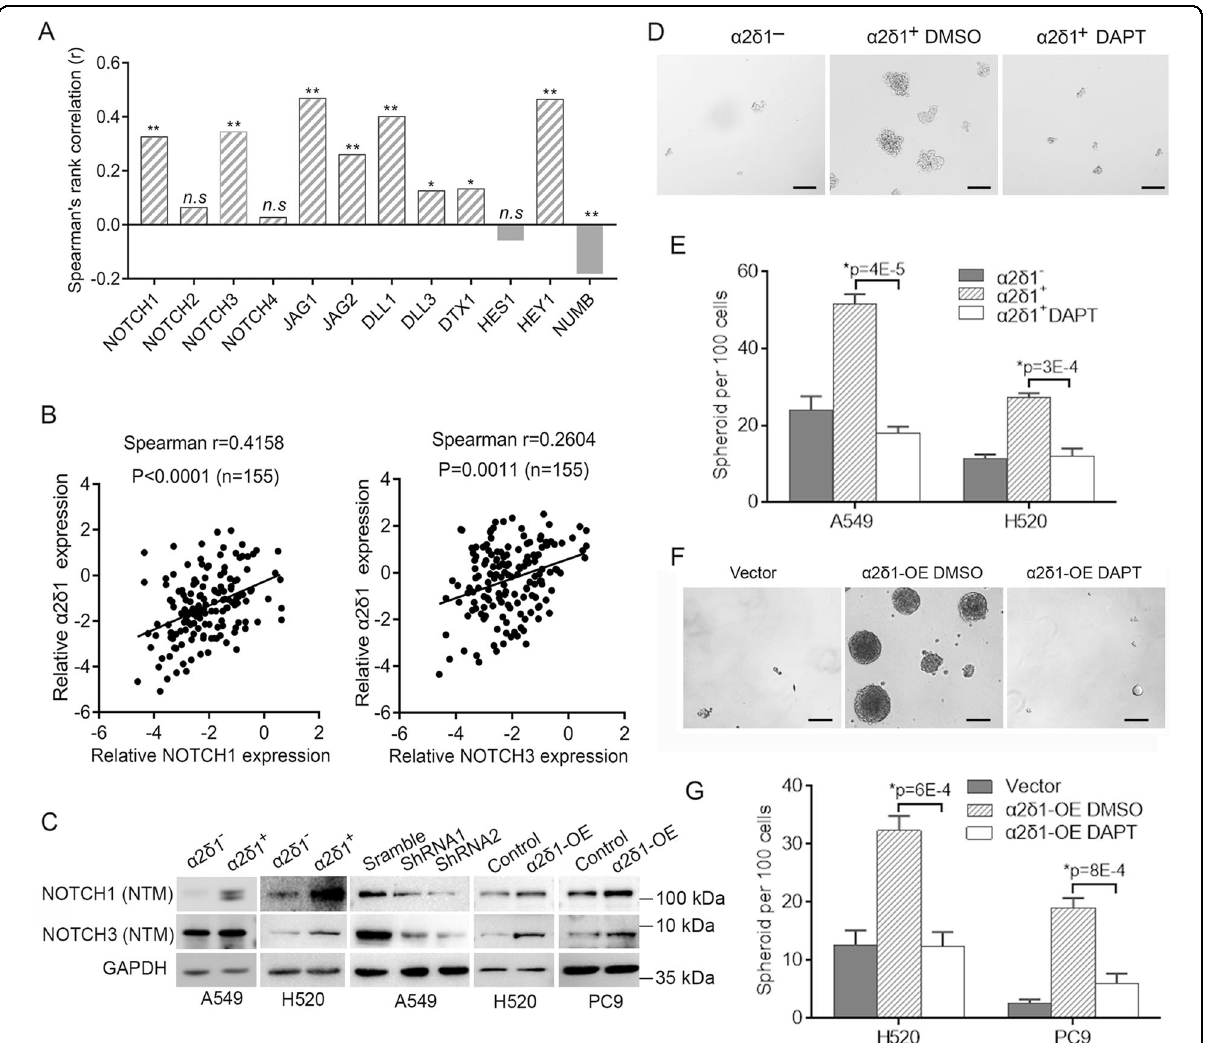
Fig. 5 The roles of α 2 δ 1 in driving TIC capacities is dependent on Notch signaling. A Histograms show the correlation of α 2 δ 1 mRNA with the genes related to Notch signaling in NSCLC tissues ( n = 349) from TCGA database. * p ≤ 0.05, ** p ≤ 0.001, n.s.>0.05. B The correlation between the expression of α 2 δ 1 and NOTCH1 , and NOTCH3 was detected by qRT-PCR in clinical NSCLC samples. C Western blot analysis of the expression of NOTCH1 and NOTCH3 in both the α 2 δ 1 + and α 2 δ 1 – subsets sorted from the indicated sources, puri fi ed α 2 δ 1 + A549 cells with α 2 δ 1 knockdown by shRNAs, and the indicated cells overexpressing α 2 δ 1. D Phase-contrast photographs showing the spheroids formed by α 2 δ 1 − , or the α 2 δ 1 + A549 cells treated with vehicle control DMSO or DAPT (10 µmol/L). Scale bars, 100 µm. E Histograms showing the spheroid formation ef fi ciencies of the puri fi ed α 2 δ 1 − , or α 2 δ 1 + cells from indicated sources treated with vehicle control DMSO or DAPT (10 µmol/L) ( n = 3). F Representative phase- contrast micrographs demonstrating the spheroids formed by H520 cells overexpressing α 2 δ 1 following DAPT treatment. Scale bars, 100 µm. G Histograms showing the spheroid forming ef fi ciencies of the indicated cells overexpressing α 2 δ 1 treated with vehicle control DMSO or DAPT ( n = 3). The error bars in ( E ) and ( G ) represents SD of three independent experiments. *Student ’ s t